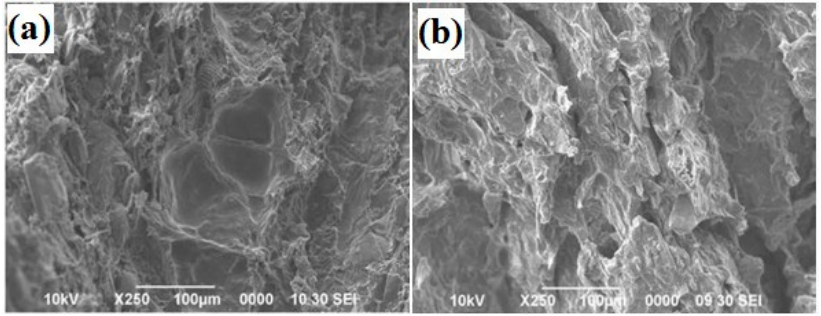
Figure 2. SEM images of the fracture surfaces of ( a ) sago pith and ( b ) PVA/sago pith (20/80 wt %) (Reprinted with permission from [45]. Copyright 2011, Wiley.). (Reprinted with permission from [45]. Copyright 2011,